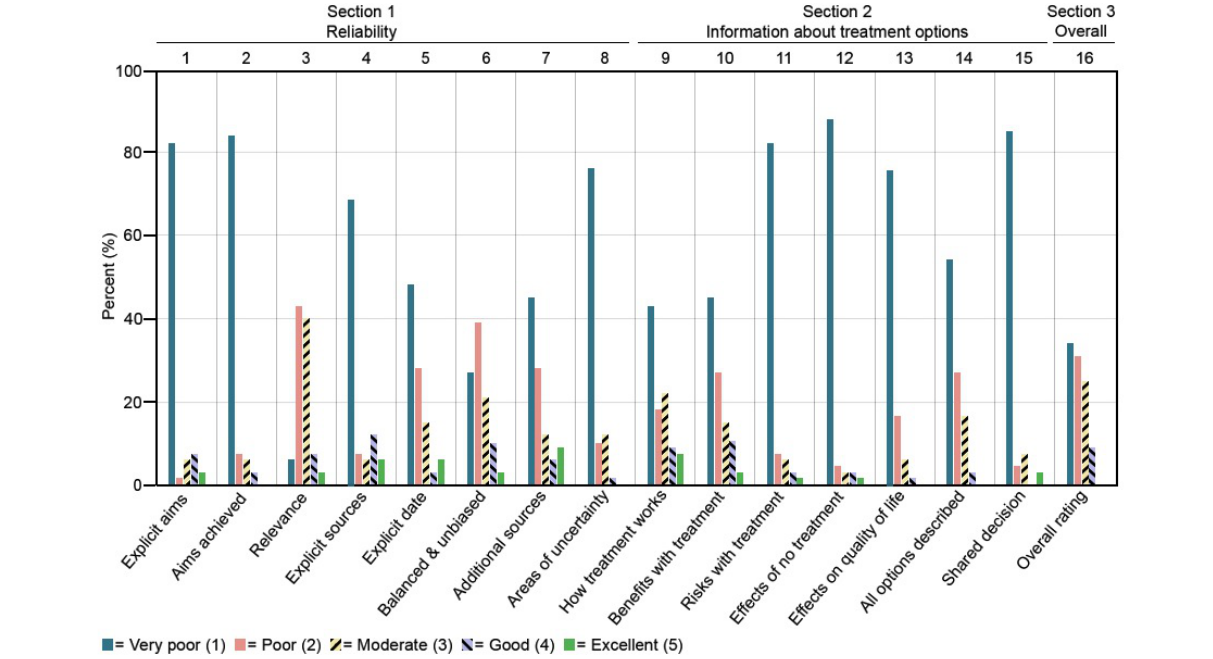
Figure 2. Proportion of websites (N=67) categorized into five categories from very poor to excellent, for each separate question in the DISCERN